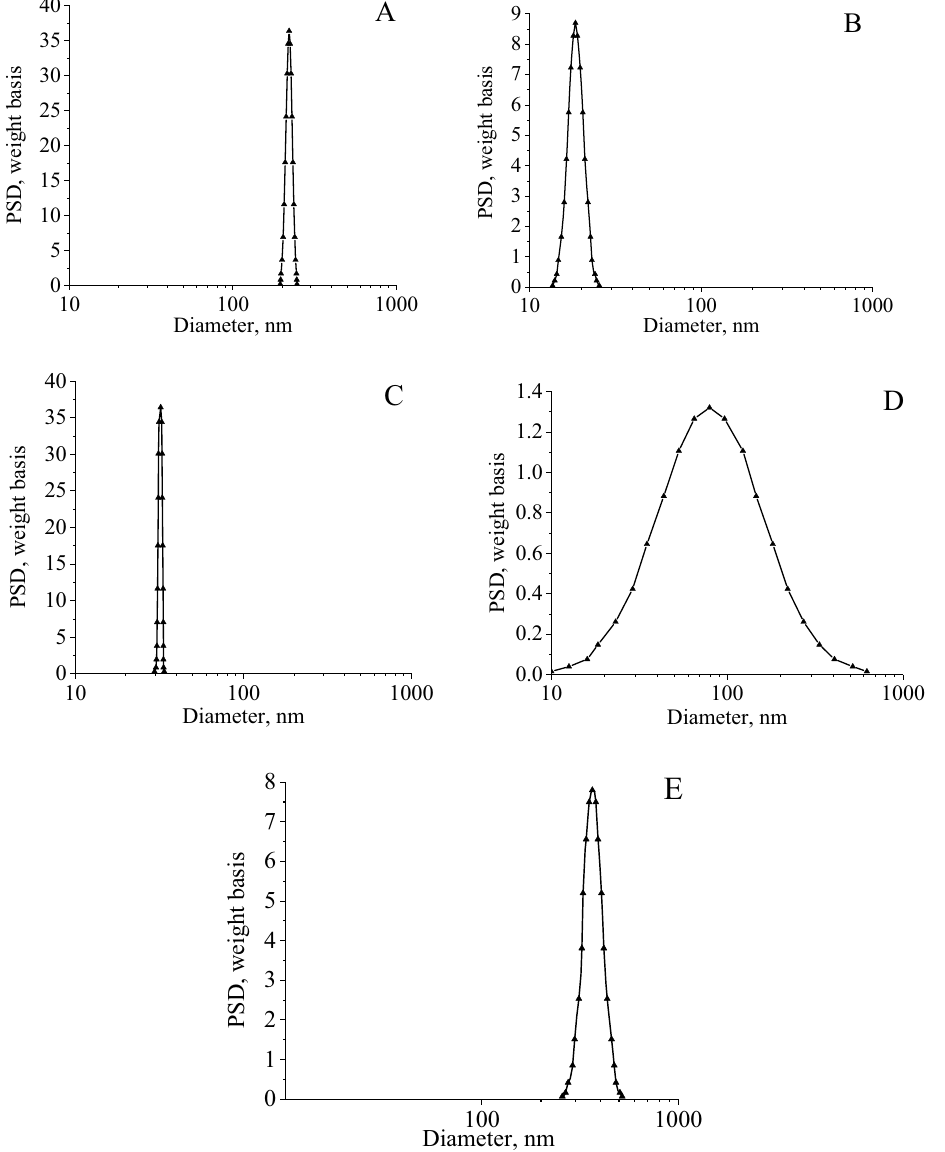
Figure 4. Size of CuO nanoparticles, synthesized in ethanol ( A ); in water ( B ); in isopropanol ( C ); in butanol ( D ); in isobutanol ( E